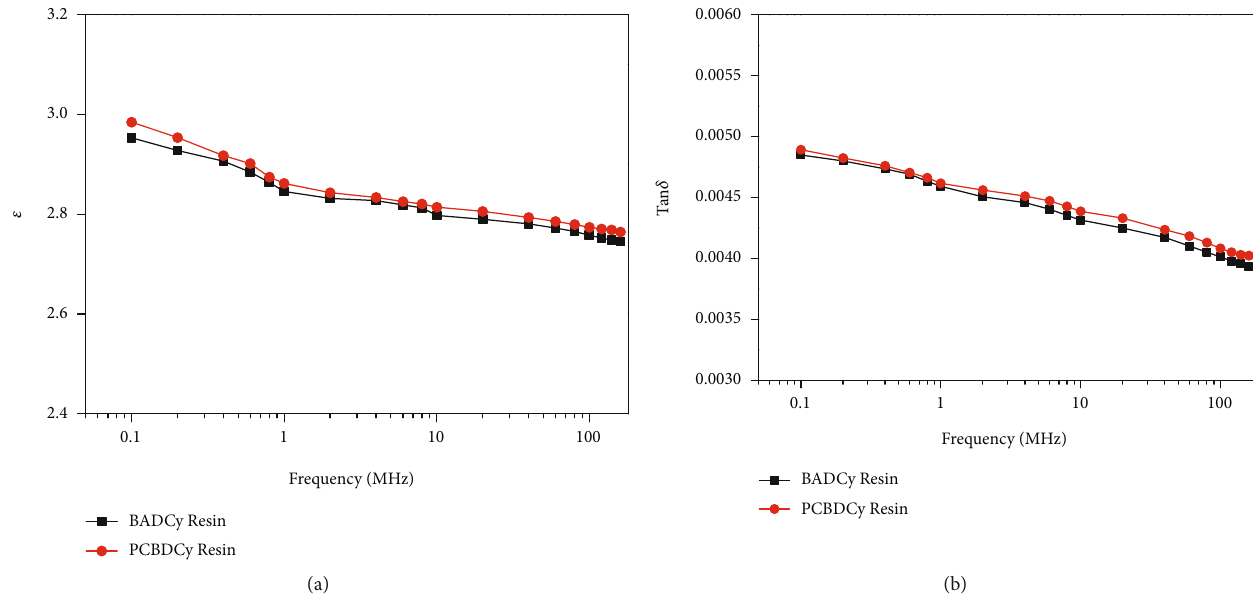
Figure 5: Dielectric constants (a) and dielectric loss tangents (b) of cured PCBDCy and BADCy.